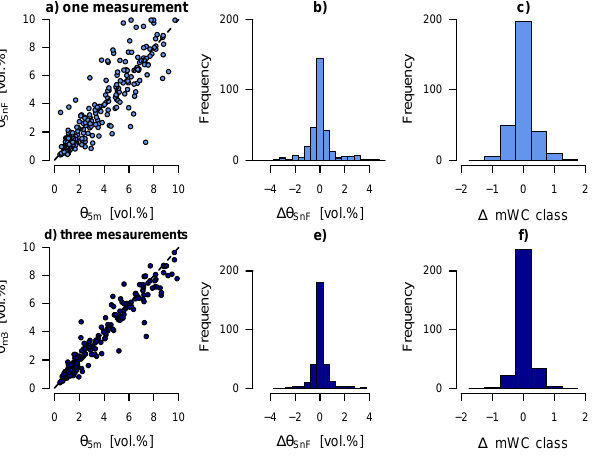
Fig. 10. Comparison between measurement samples and the me- Fig. 12. Comparison between measurement samples and the me- dian of a 5m cross-section at a certain depth θ 5m . Upper row plots dian of a 5 m cross-section at a certain depth θ 5 m . Upper row plots (a–c) show the comparison for one randomly selected measurement (a-c) show the comparison for one randomly selected measurement to θ 5 m , lower row plots (d-f) compare the median of three measure- to θ 5m , lower row plots (d–f) compare the median of three measure- ments ( θ m 3 ) observed at 1 m horizontal distance to θ 5 m . Scatter- ments ( θ m3 ) observed at 1m horizontal distance to θ 5m . Scatter- plots show the absolute values (a, d), the histograms the difference plots show the absolute values (a, d) , the histograms the difference between θ -values ( ∆ θ , plots b and e) and the difference in wetness between θ -values ( 1θ , plots (b) and (e) ) and the difference in wet- classes ( ∆ mWC) using the international classification (Fierz et al., ness classes ( 1 mWC) using the international classification (Fierz 2009, plots c, f). et al., 2009, plots (c, f) ).